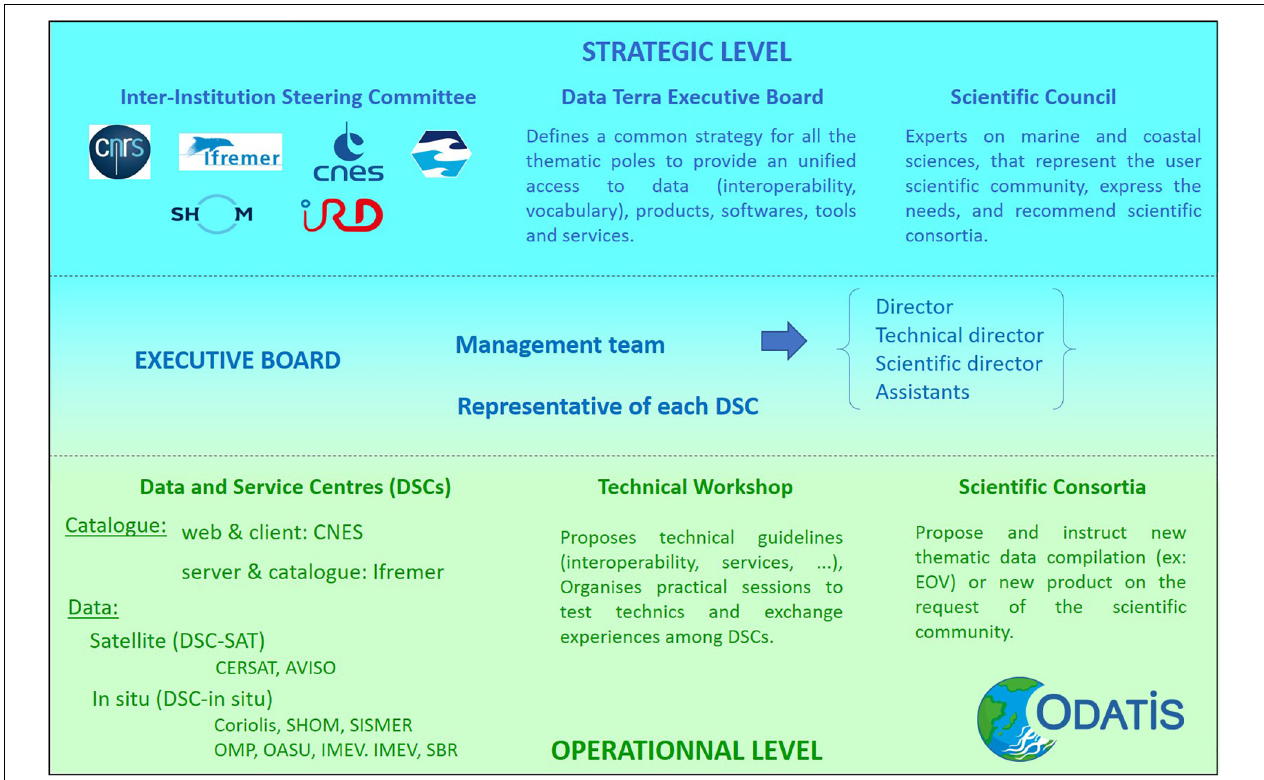
FIGURE 2 | Strategic and operational organization of the ocean cluster